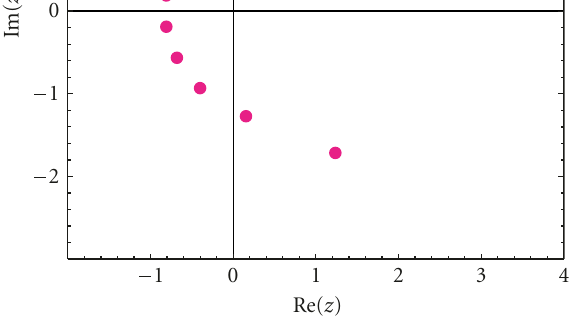
Figure 4.5 . Zeros of E 10, q , w ( x ).